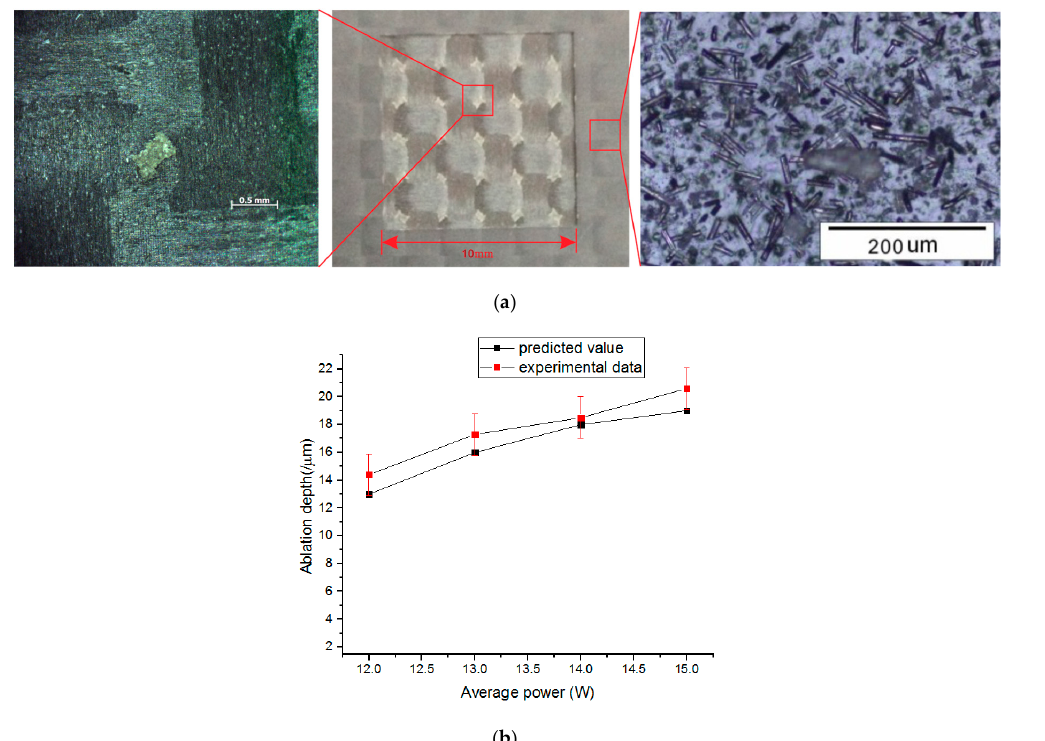
Figure 8. ( a ) Laser milling CFRP sample; ( b ) Predicted ablation depth vs. experimental data at different laser powers.